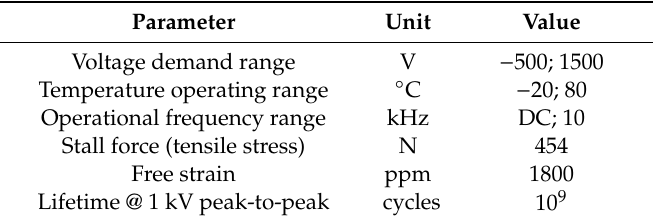
Figure 3. Experimental set-up [40]: ( a ) morphing laminate with MFC patches; ( b ) rig top view: MFC laminate (A); external laser sensors (B); precision translation stage (C). Table 1. MFC patch operational